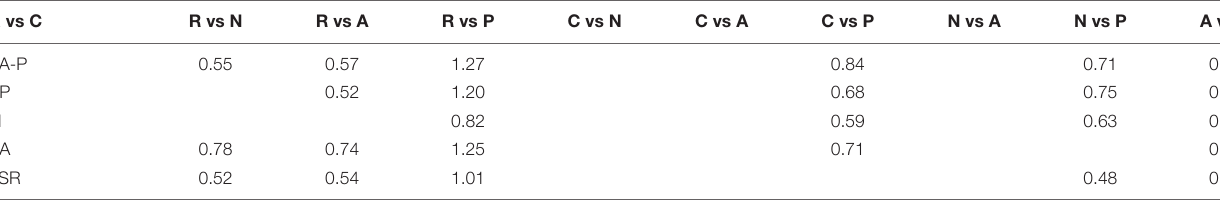
TABLE 4 | Cohen’s d value for post hoc contrasts between sociometric groups on EA-P dimensions.